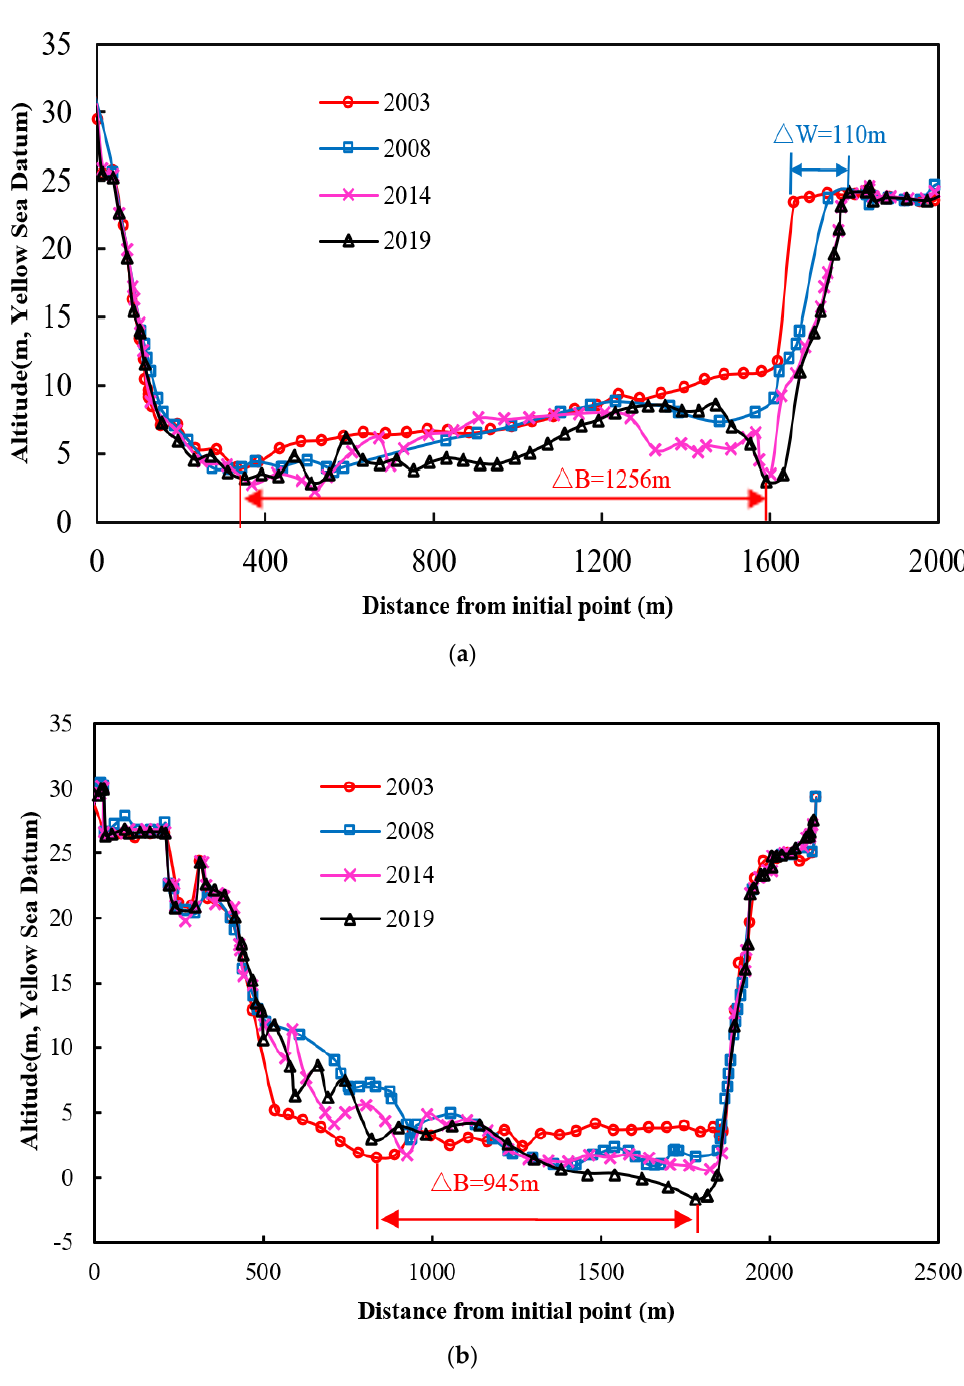
Figure 8. Morphological adjustments of typical cross-sections in the Wuhan reach. ( a ) HLZ06 and ( b ) HLZ12-1.